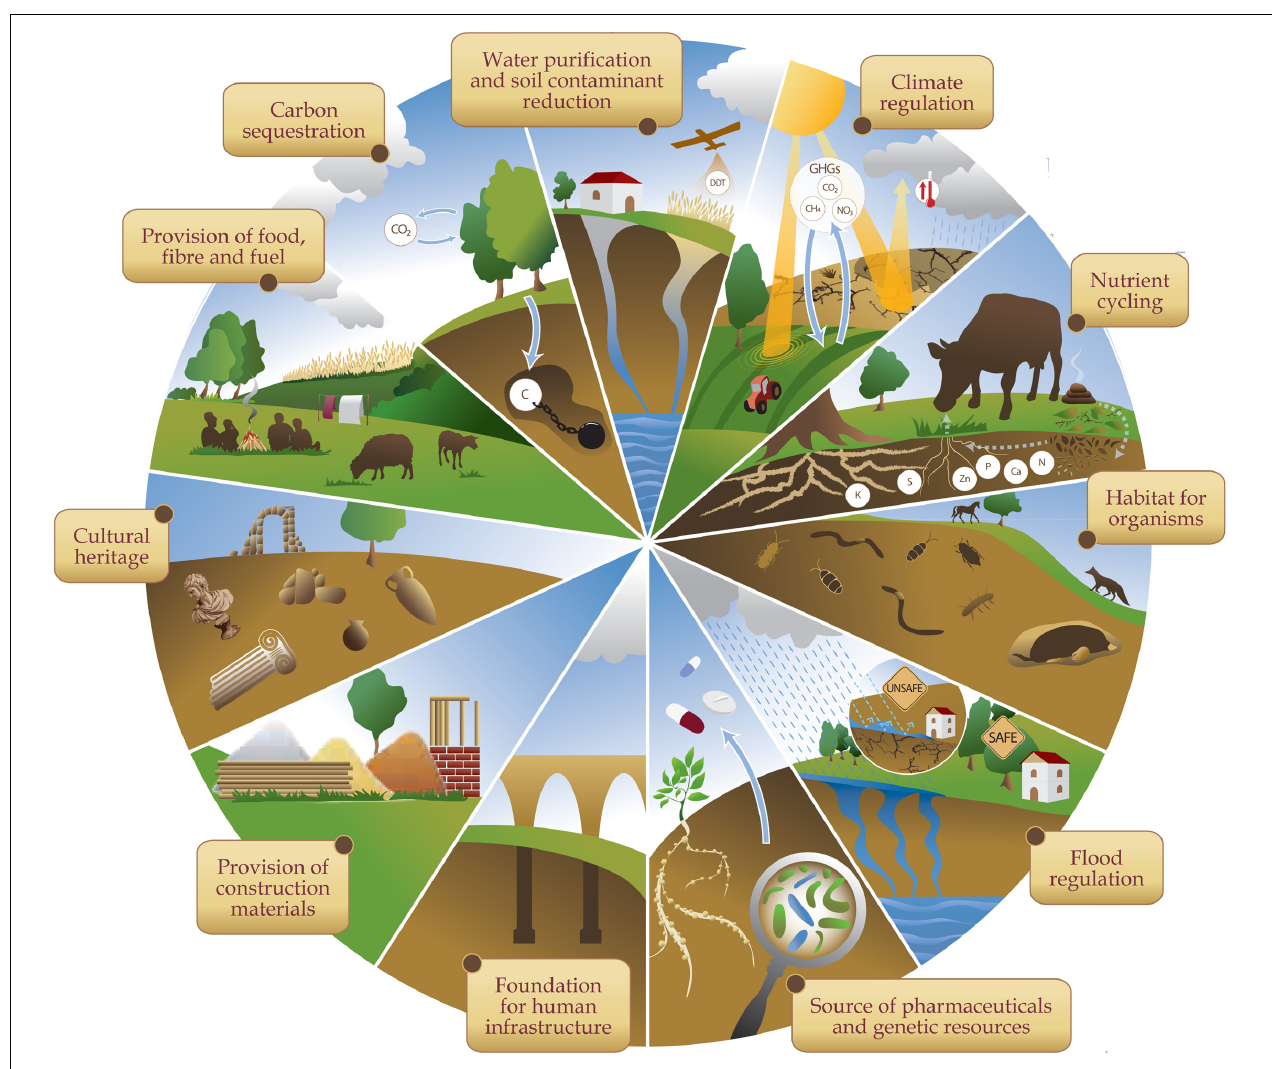
FIGURE 1 | Schematic diagram of soil functions. This diagram is part of an uncommented “infographics” on soil functions put together by the FAO, with the subtitle “Soils deliver ecosystem services that enable life on earth.” This particular diagram considers “carbon sequestration” and “climate regulation” functions separately (Adapted from